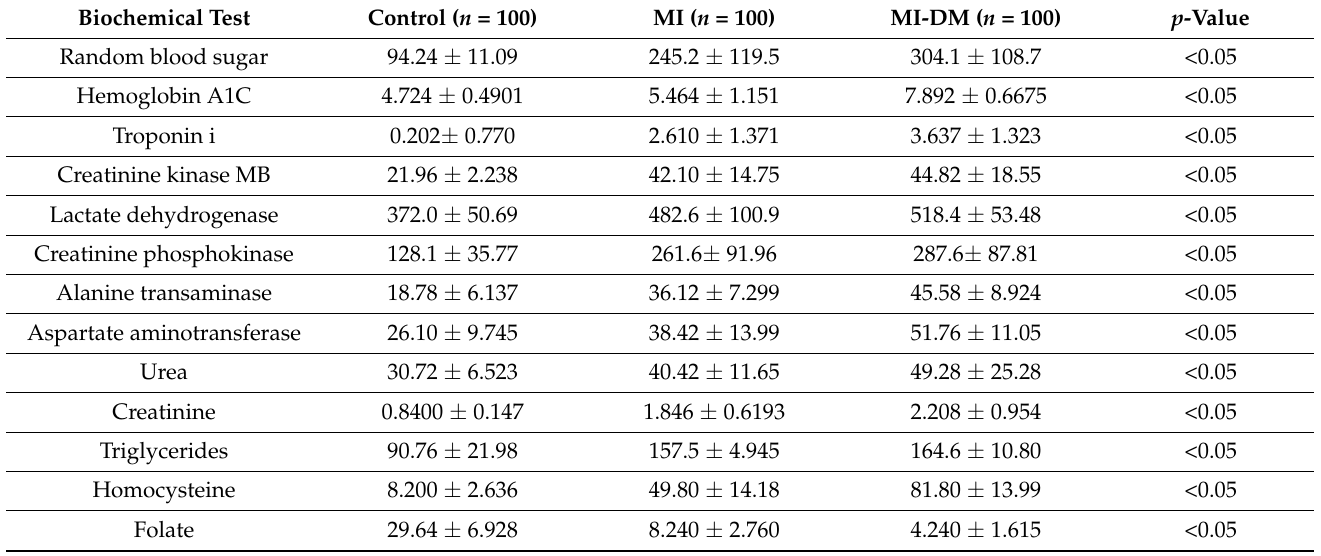
Table 3. Biochemical analysis of the control, myocardial infarction (MI), and myocardial infarction with diabetes mellitus (MI-DM) study